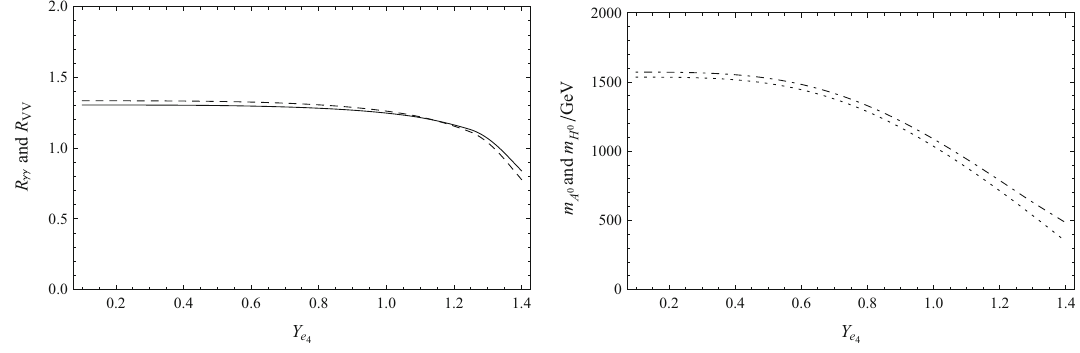
Fig. 3 The results versus Y e are shown. R γγ (solid line) and R VV (dashed line) are in the left diagram. m A 0 (dot-dashed line) and m H 0 (dotted 4 line) are in the right